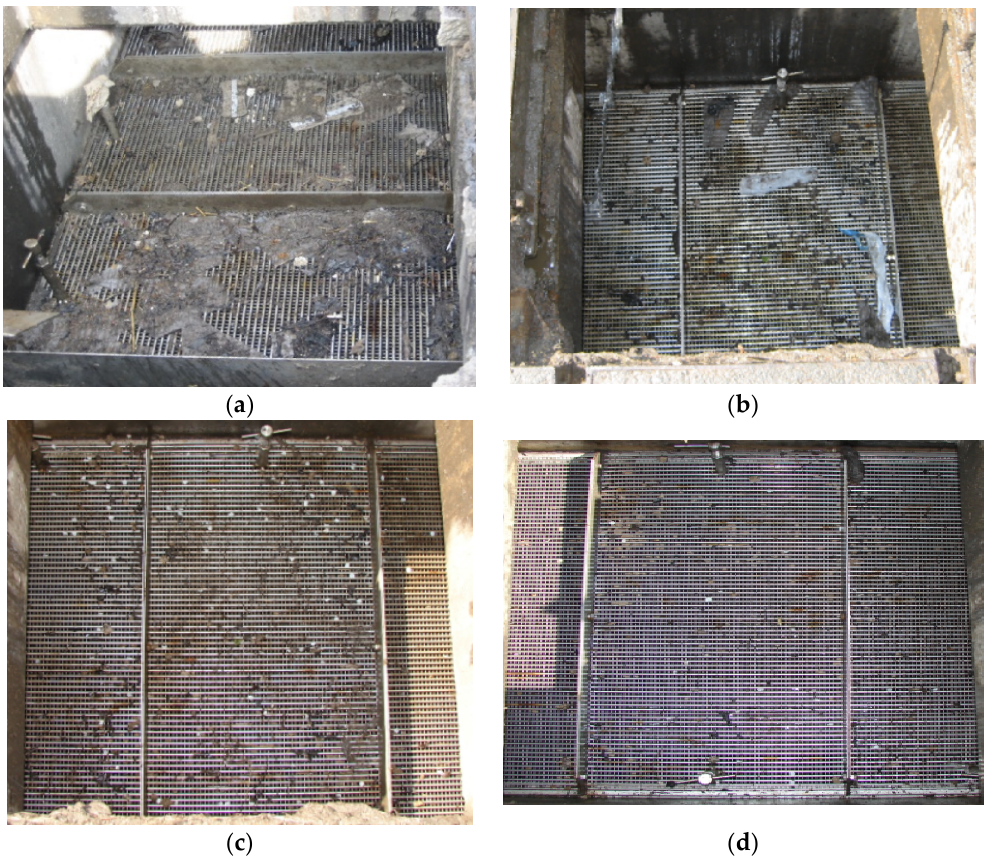
Figure 6. Phase 1: CSO screen conditions on site 1 in an urban area in West Yorkshire. ( a ) Unclean condition; ( b ) first level of cleaning; ( c ) second level of cleaning; ( d ) fully clean.